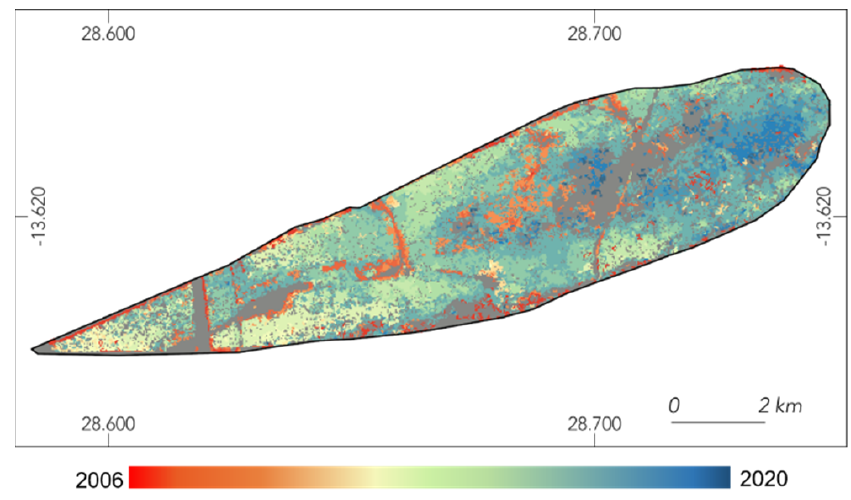
Figure 5. Evolution of annual forest degradation extent in Katarino forest reserve from 2006 to 2020 based on change analysis of multitemporal Landsat 5 and 8 imagery. Grey areas represent remaining tree cover.